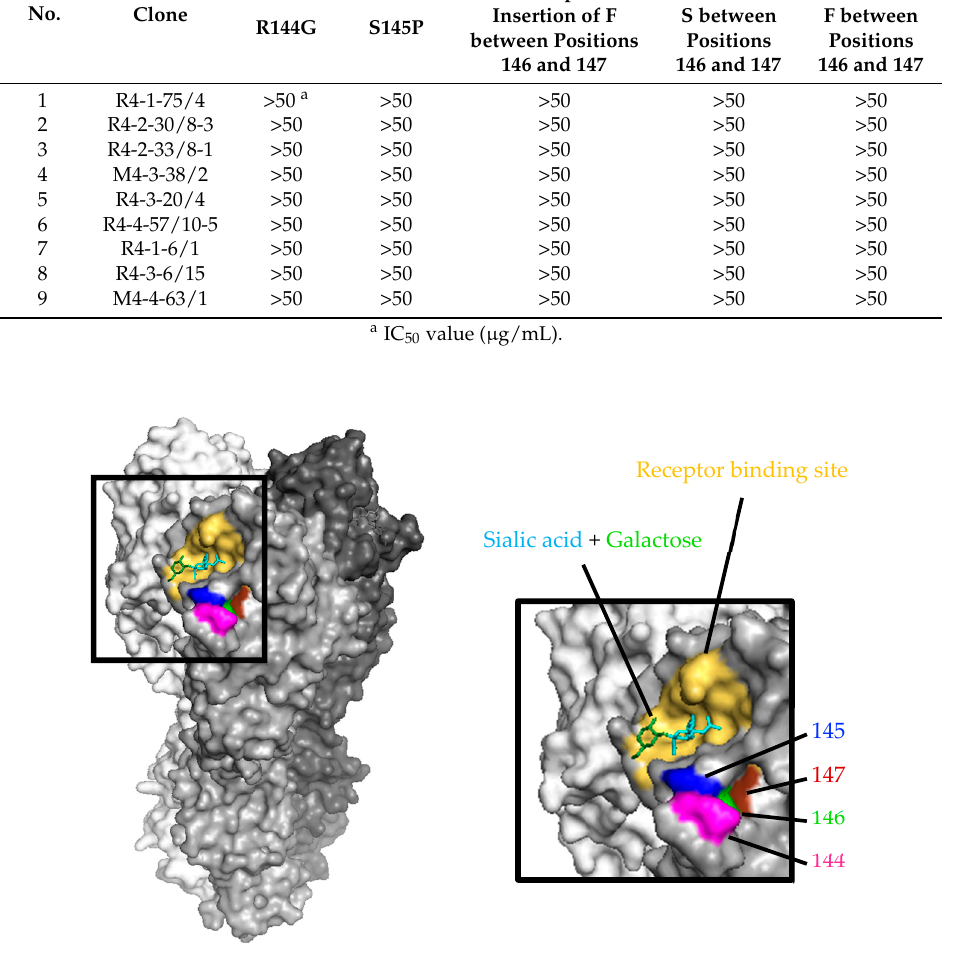
Table 8. Amino acid variation at positions 144 to 147 of H5-HA. Subclade